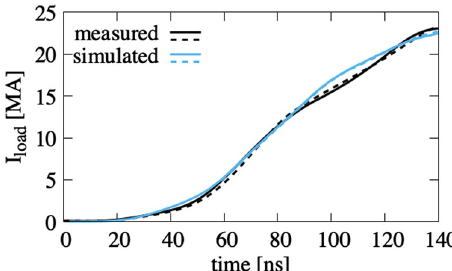
FIG. 12. (a) Ion density contours in the inner MITL at 100 ns with (b) a magnified view. This is the inner MITL from the geometry in Fig. 3(a). The densities are plotted on a log scale from 10 13 − 10 17 cm − 3 .